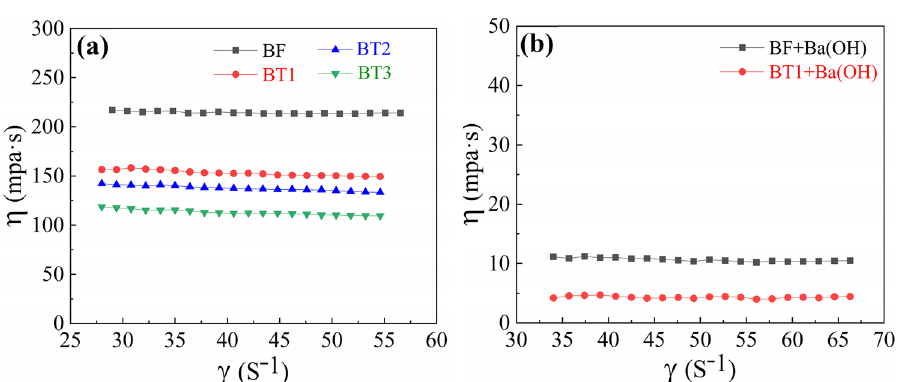
Figure 4. The viscosity of the microemulsions (BF, BT1, BT2, BT3, BF + Ba(OH) and BT1 +